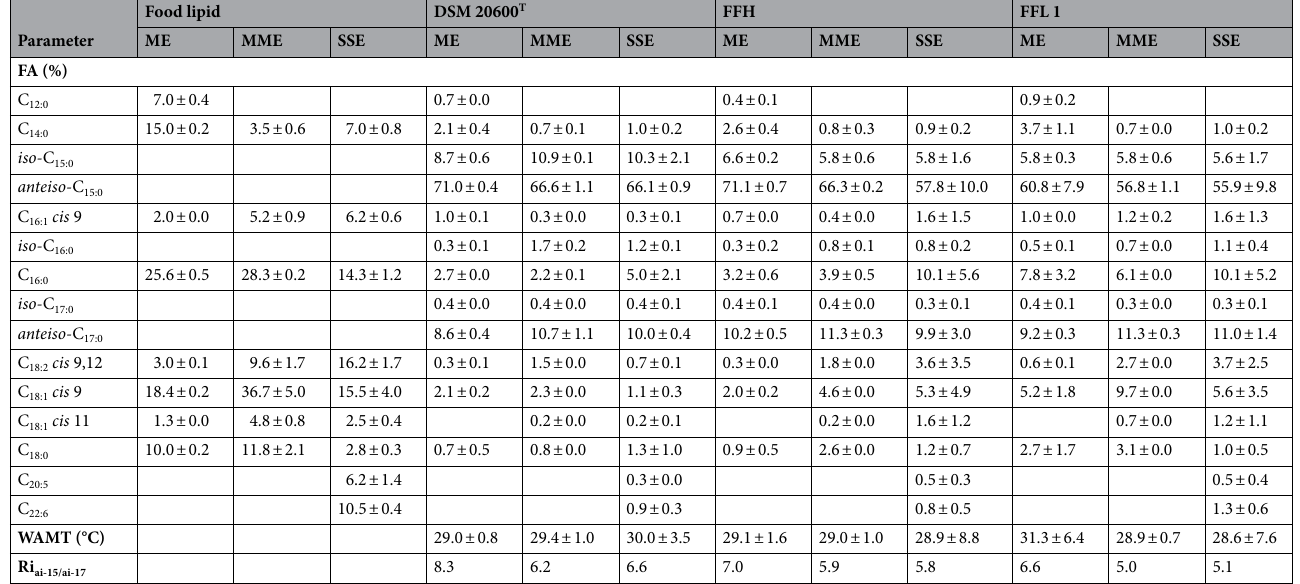
Table 3. Fatty acid (FA) composition, weighted-average melting temperature (WAMT), and the ratio of anteiso -C 15:0 to anteiso -C 17:0 (Ri ai-15/ai-17 ). Tryptic soy broth-yeast extract medium supplemented with food lipid extracts and Listeria monocytogenes strains DSM 20600 T , FFH, and FFL 1 grown at 6 °C on tryptic soy agar- yeast extract medium supplemented with 0.1% (wt/vol) milk extract (ME), with 0.1% (wt/vol) minced meat extract (MME) or with 0.1% (wt/vol) smoked salmon extract (SSE). Values are means ± standard deviation ( n =